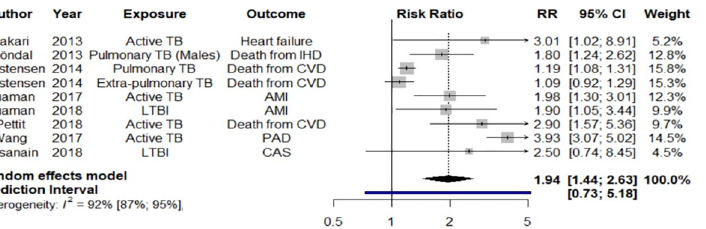
Fig 3. Forest plot of per-protocol meta-analysis for systematic literature review of tuberculosis and risk of cardiovascular disease and related mortality. AMI = acute myocardial infarction, CAS = coronary artery stenosis, CBVE = cerebrovascular event, CI = confidence interval, CVD = cardiovascular disease, IHD = ischemic heart disease, PAD = peripheral arterial disease, RR = risk ratio, TB = tuberculosis. Black diamond = pooled RR and 95% confidence interval; blue bar = 95% prediction interval.